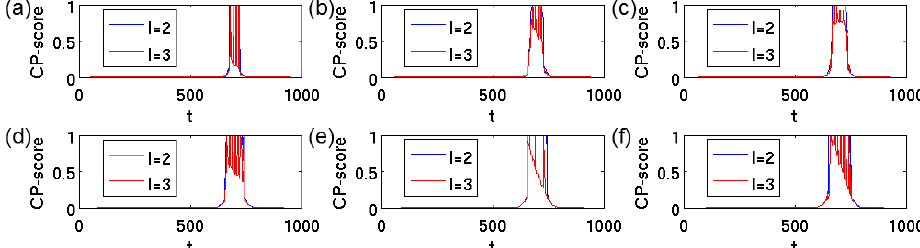
Fig. 11. CP-scores of ˜ Y 2 . (a) b = 50, L SST = 25, (b) b = 60, L SST = 30, (c) b = 70, L SST = 35, (d) b = 80, L SST = 40, (e) b = 90, L SST = 45, and (f) b = 100, L SST = 50, and then always γ = 0 and l = 2 (blue line), 3 (red line).